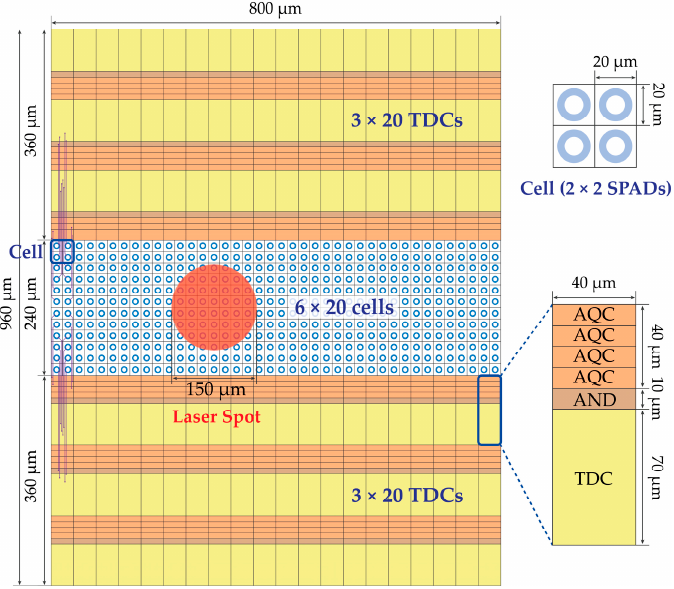
Figure 7. Example of multi-photon SPAD array ( left ), with one TDC shared among a low number (e.g., 2 × 2) of SPADs ( right ); the TDC is triggered by a digital combination (e.g., and AND gate) of the AQCs’ outputs.